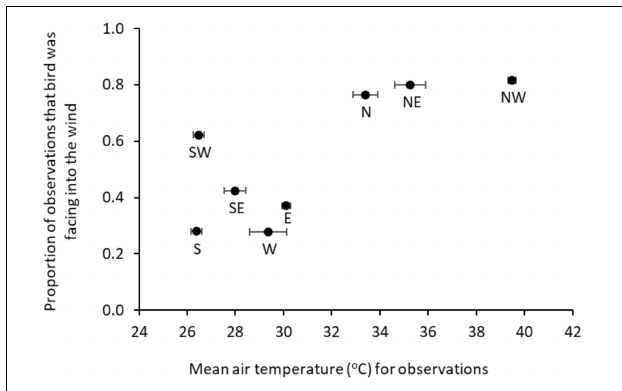
FIGURE 6 | Wind direction: mean air temperature recorded for observations made when the wind was coming from a particular direction, and proportion of those observations in which the bird was facing into the wind (25% expected by chance). Error bars show SE for air temperature.